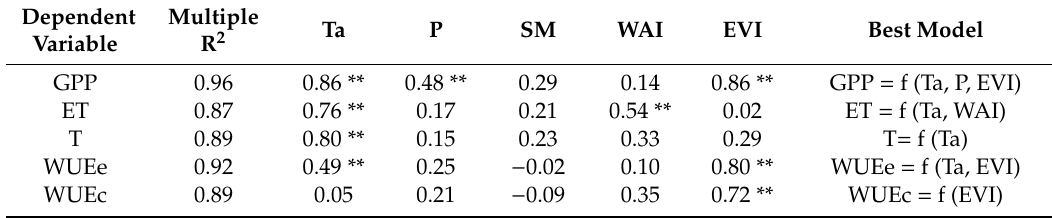
Table 3. Statistics of partial correlation analysis and the multiple regression models. The symbol ** indicates the statistical significance level of 0.01 for each variable. The climatic parameters included monthly mean air temperature (Ta), precipitation (P), soil moisture at 4 cm layer (SM), water availability index (WAI), and enhanced vegetation index (EVI) during the growing seasons (i.e., periods from May to September). GPP, ET and T represent gross primary production, evapotranspiration and transpiration, respectively. WUEe and WUEc represent ecosystem and canopy water use e ffi ciency (WUE), respectively. The best model represented the multiple models that removing the redundant variables.